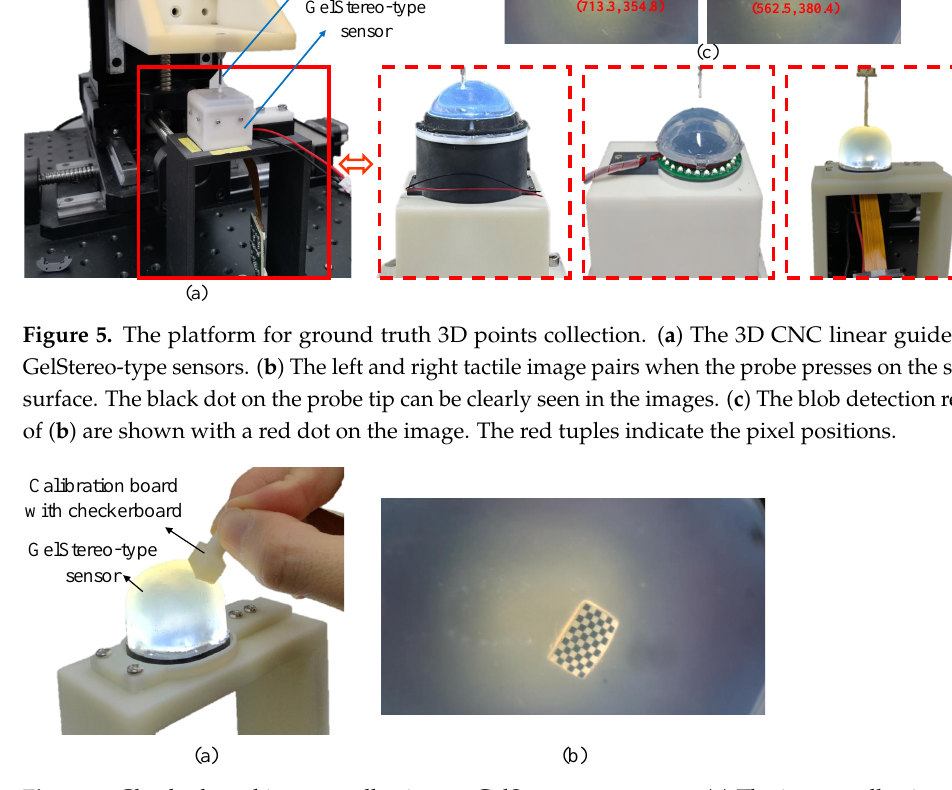
Figure 6. Checkerboard images collection on GelStereo-type sensor. ( a ) The image collection scene. ( b ) Right tactile image of the